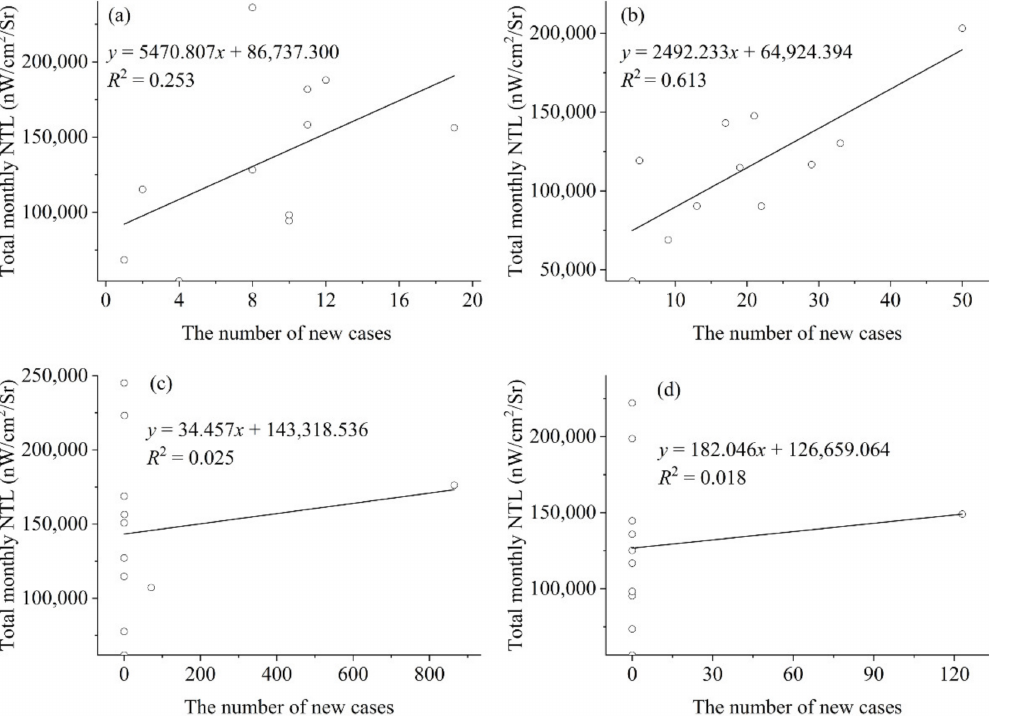
Figure 10. Relationships between total monthly NTL and new COVID-19 cases in prefecture-level cities in Hebei Province ( a ) in January 2020, ( b ) in February 2020, ( c ) in January 2021, and ( d ) in November